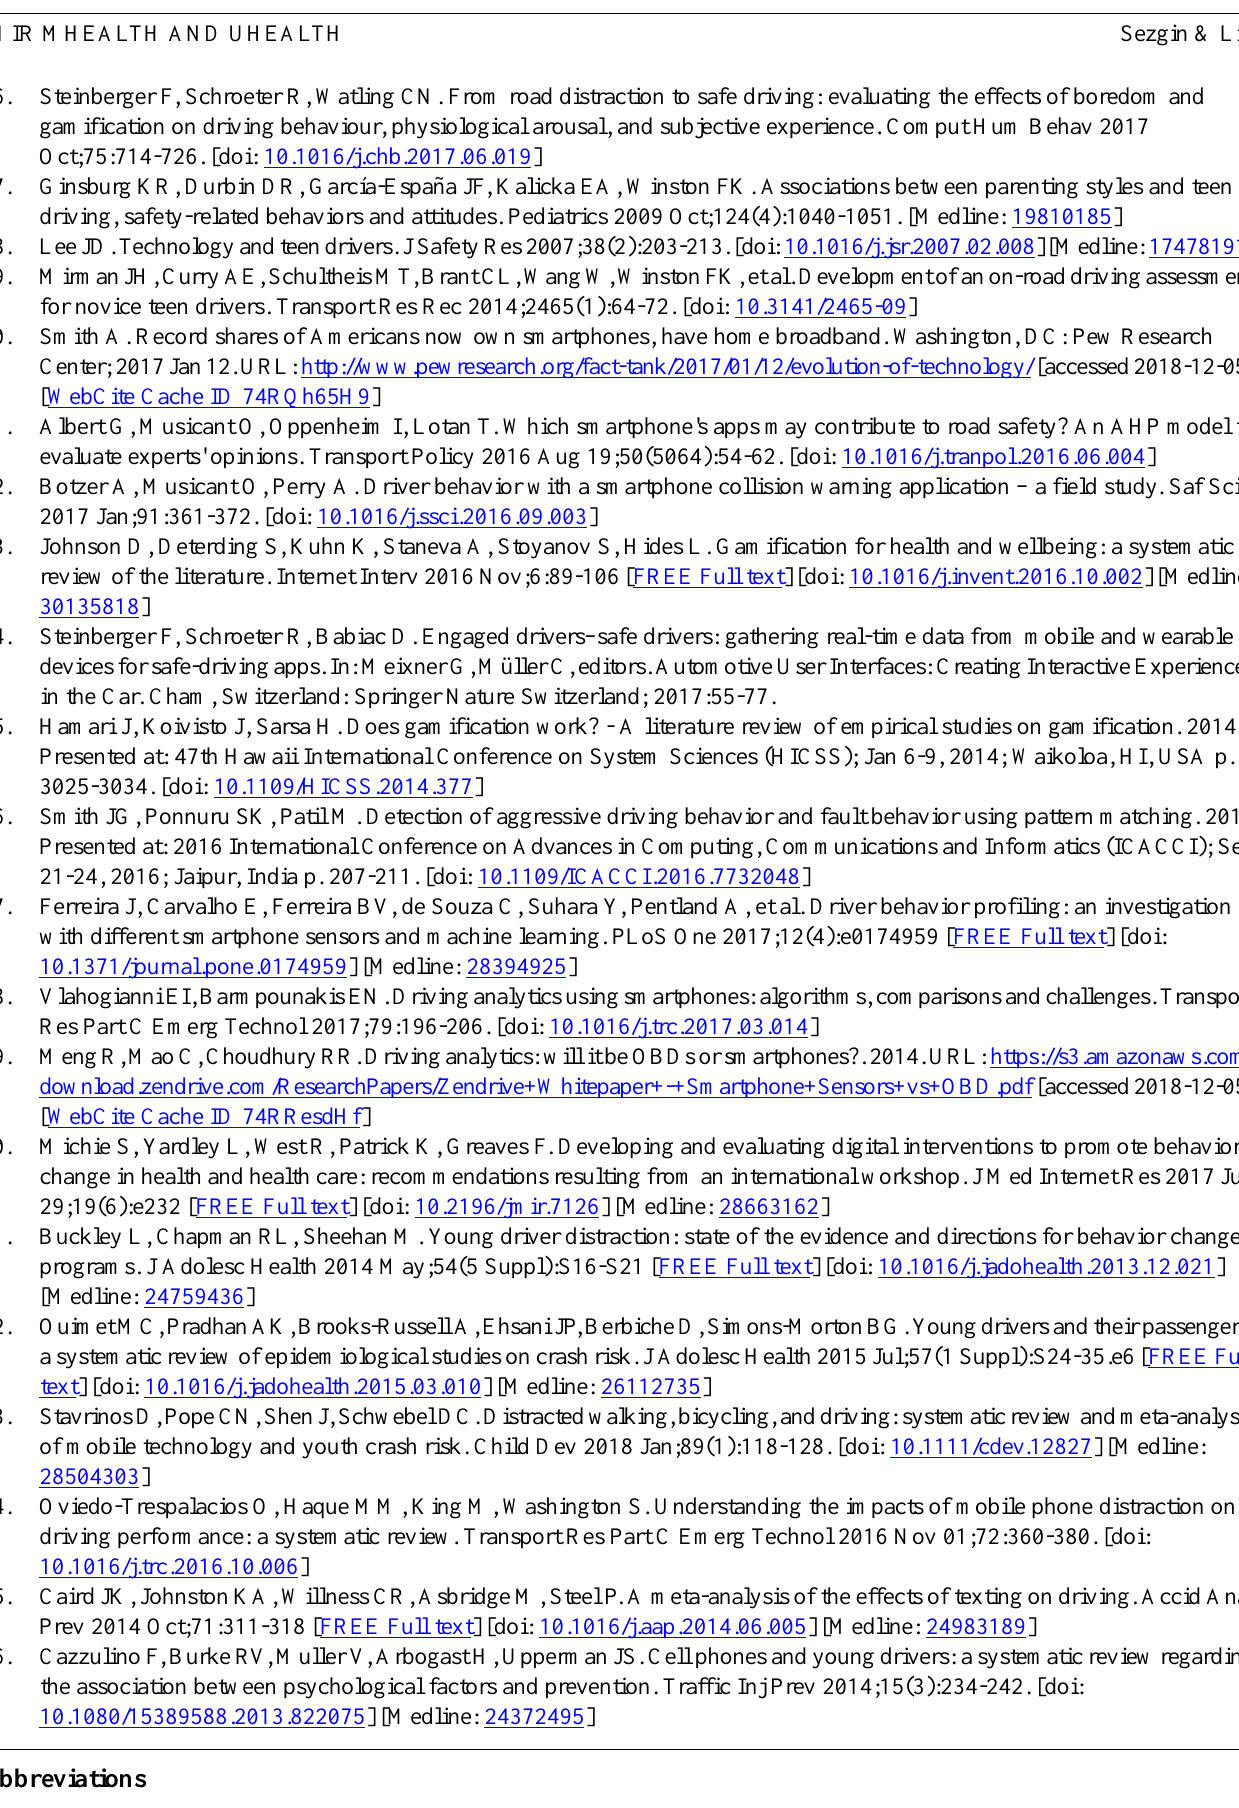
ADAS: advanced driver-assistance